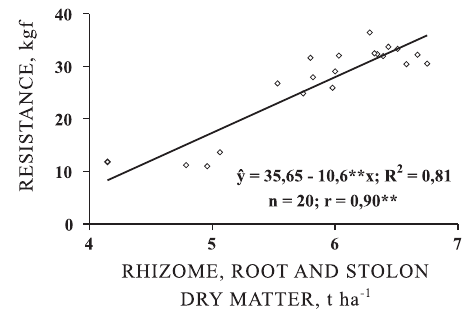
Figure 5. Relationship between mat resistance and rhizome, root and stolon dry matter of Bermuda